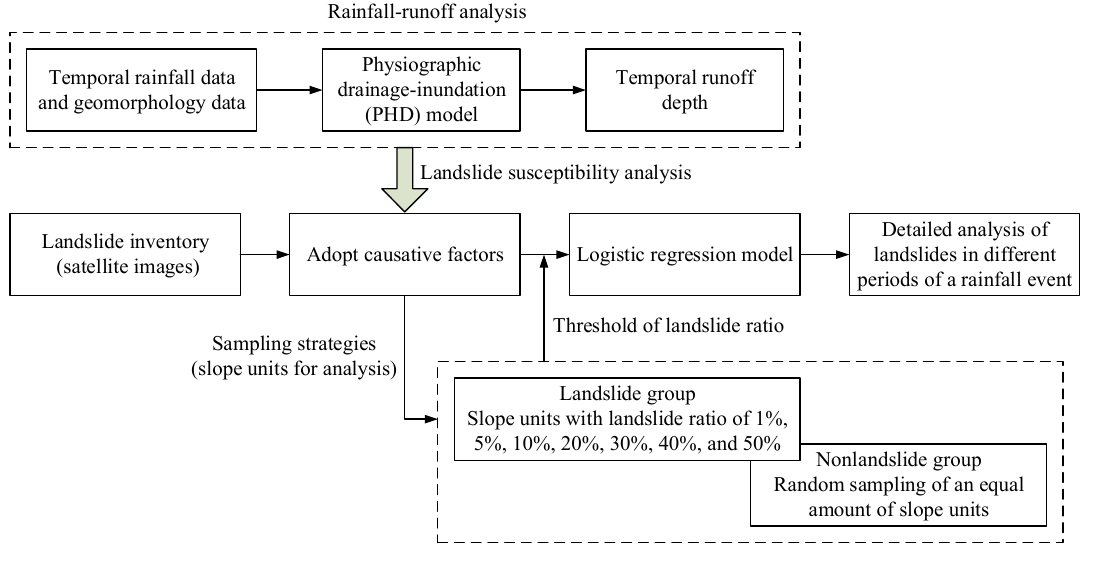
Figure 1. The flowchart of this study.